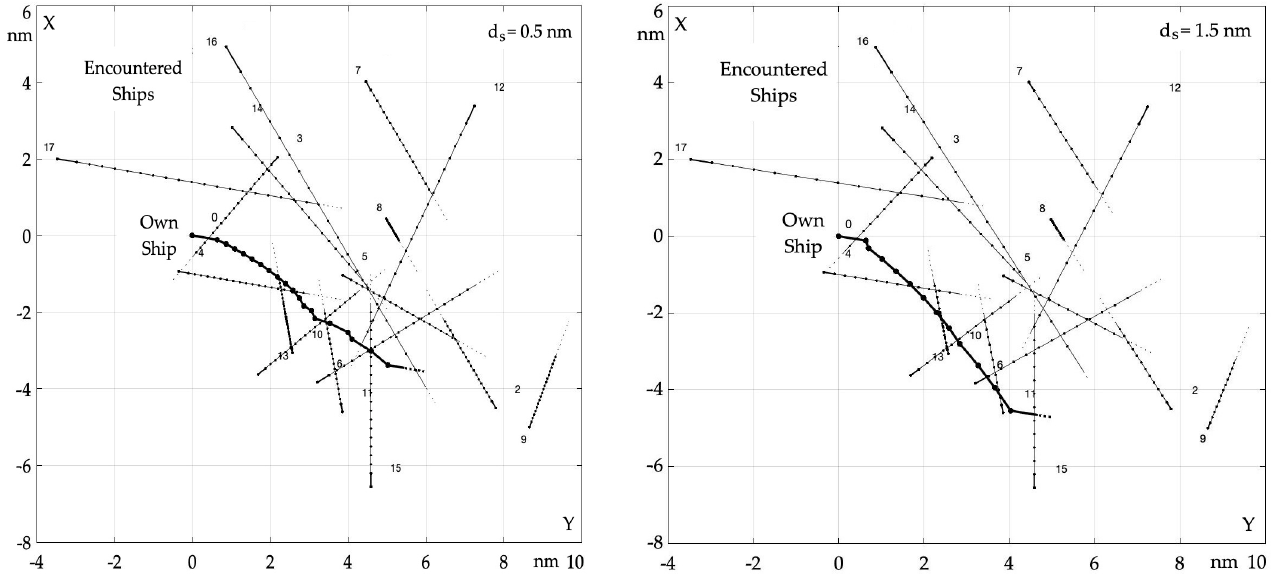
Figure 12. Autonomous surface ship safe path when passing K = 17 encountered other autonomous surface ships in good ( d s = 0.5 nm) and restricted ( d s = 1.5 nm) visibility at sea, determined by NG_oc algorithm of non-game control.